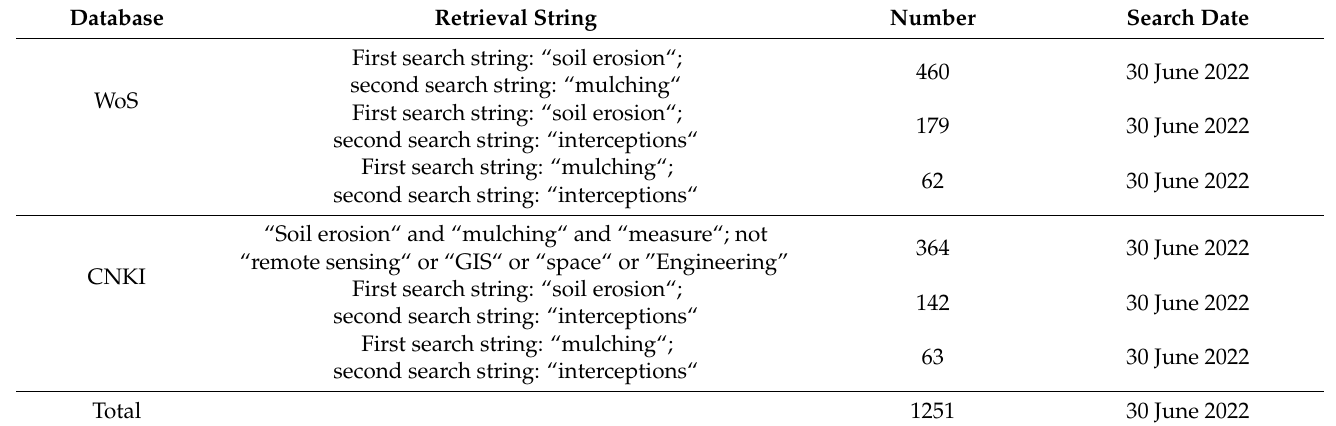
Table 1. Literature search